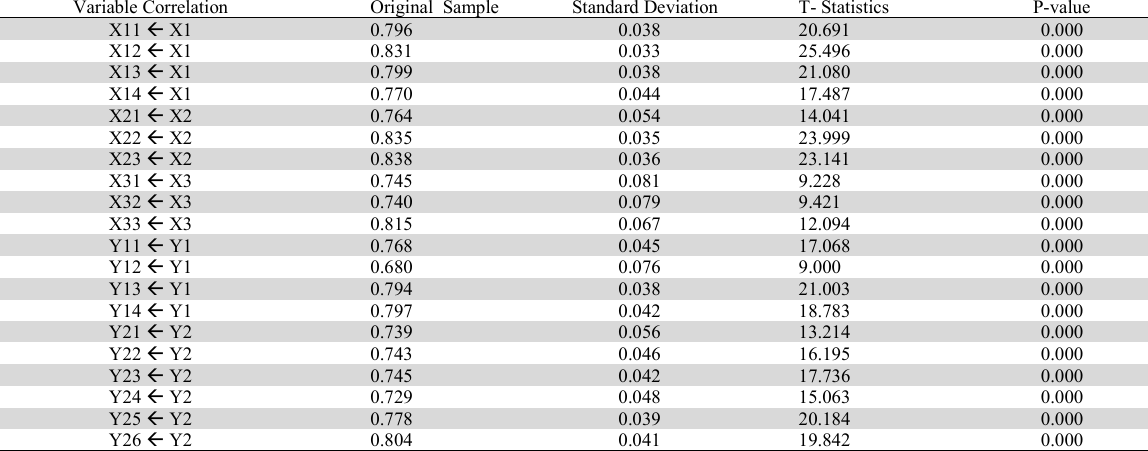
Factors in Loading Constructions Variable Correlation Original